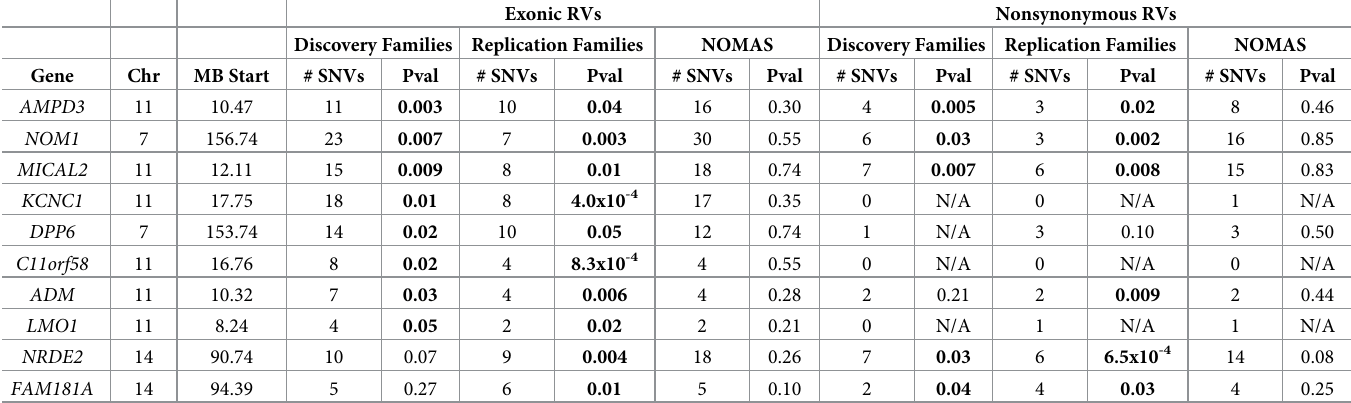
Table 3. Gene-based association results for rare variant analysis in the four linkage regions, for genes with p < 0.05 in the discovery families and p < 0.05 in the rep- lication families or